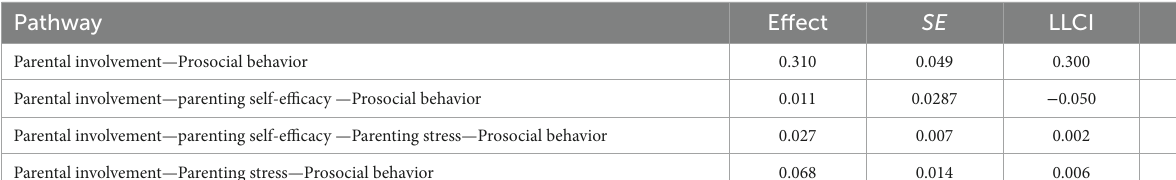
TABLE 4 Standardized indirect effects and 95% CIs for the mediational model. Pathway